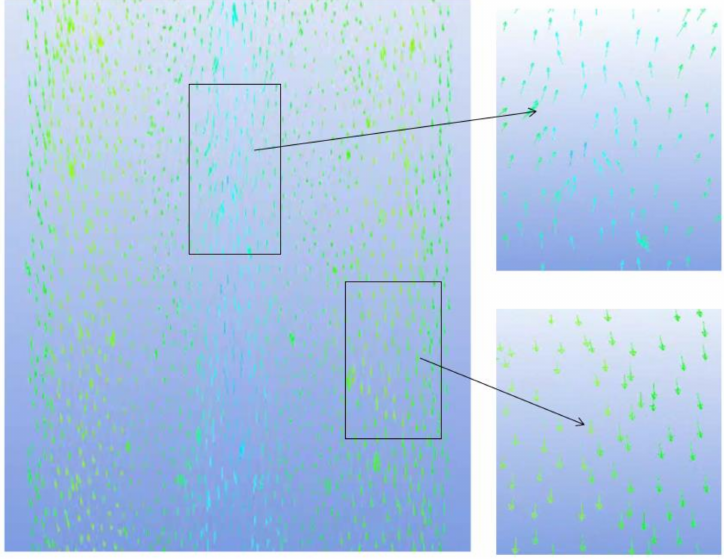
Figure 6. Backflow phenomenon vector